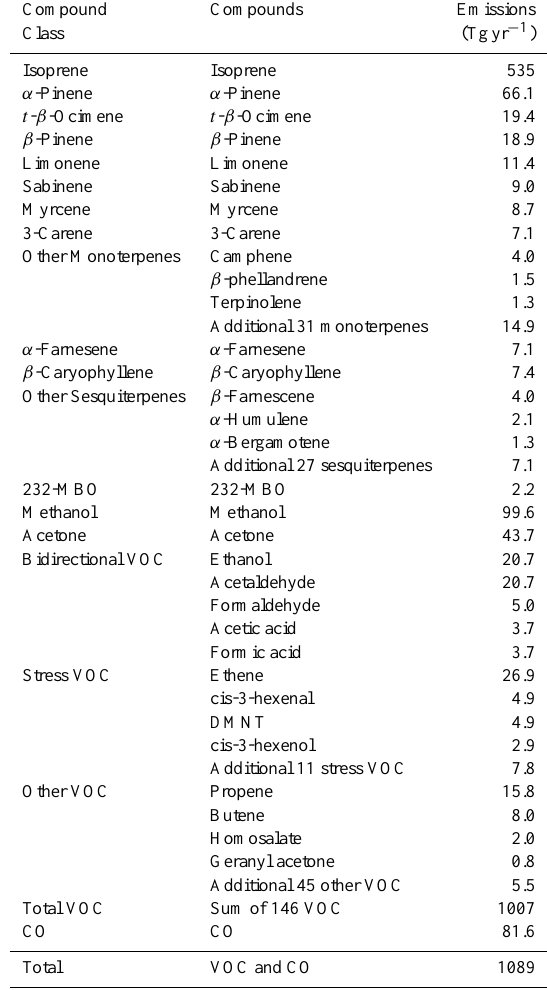
Table 6. Global annual total emissions simulated for the year 2000 using MEGAN2.1 algorithms in